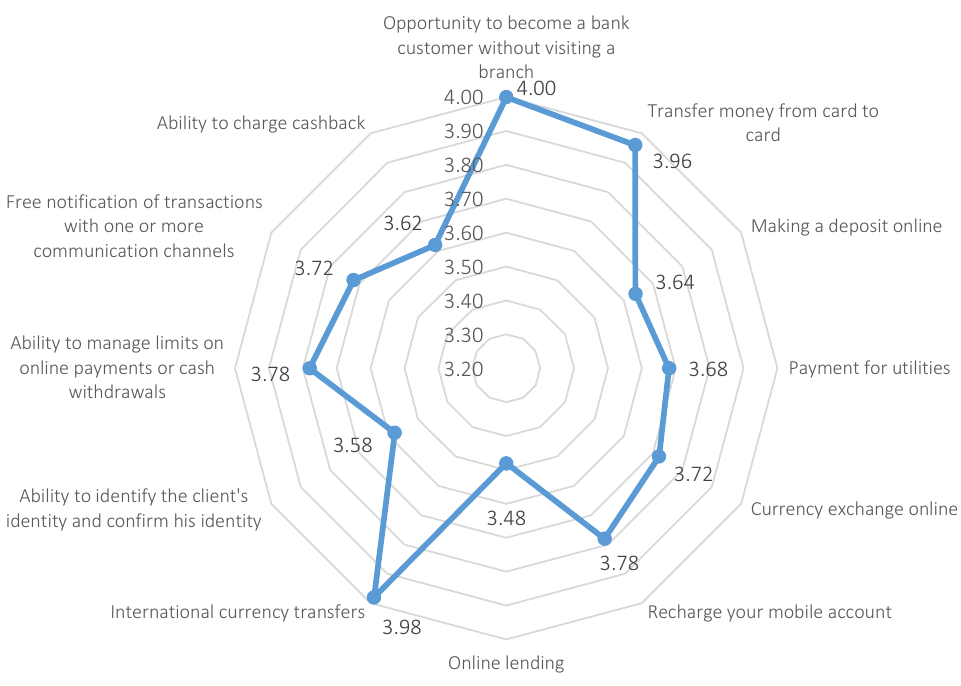
Figure 3. The impact of effective interaction between the bank and customers on specific areas of digital activity of Ukrainian